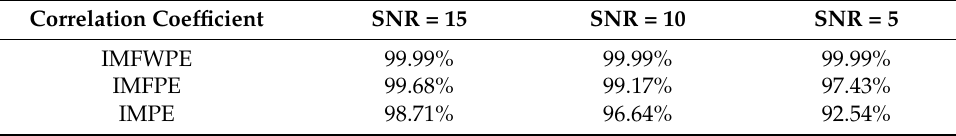
Figure 4. Entropy distribution of IMFWPE, IMFPE, and IMPE for different signal-to-noise ratio signals: ( a ) IMPE entropy distribution; ( b ) IMFPE entropy distribution; ( c ) IMFWPE entropy distribution. Table 1. Entropy correlation coefficient of vibration signal before and after noise addition.